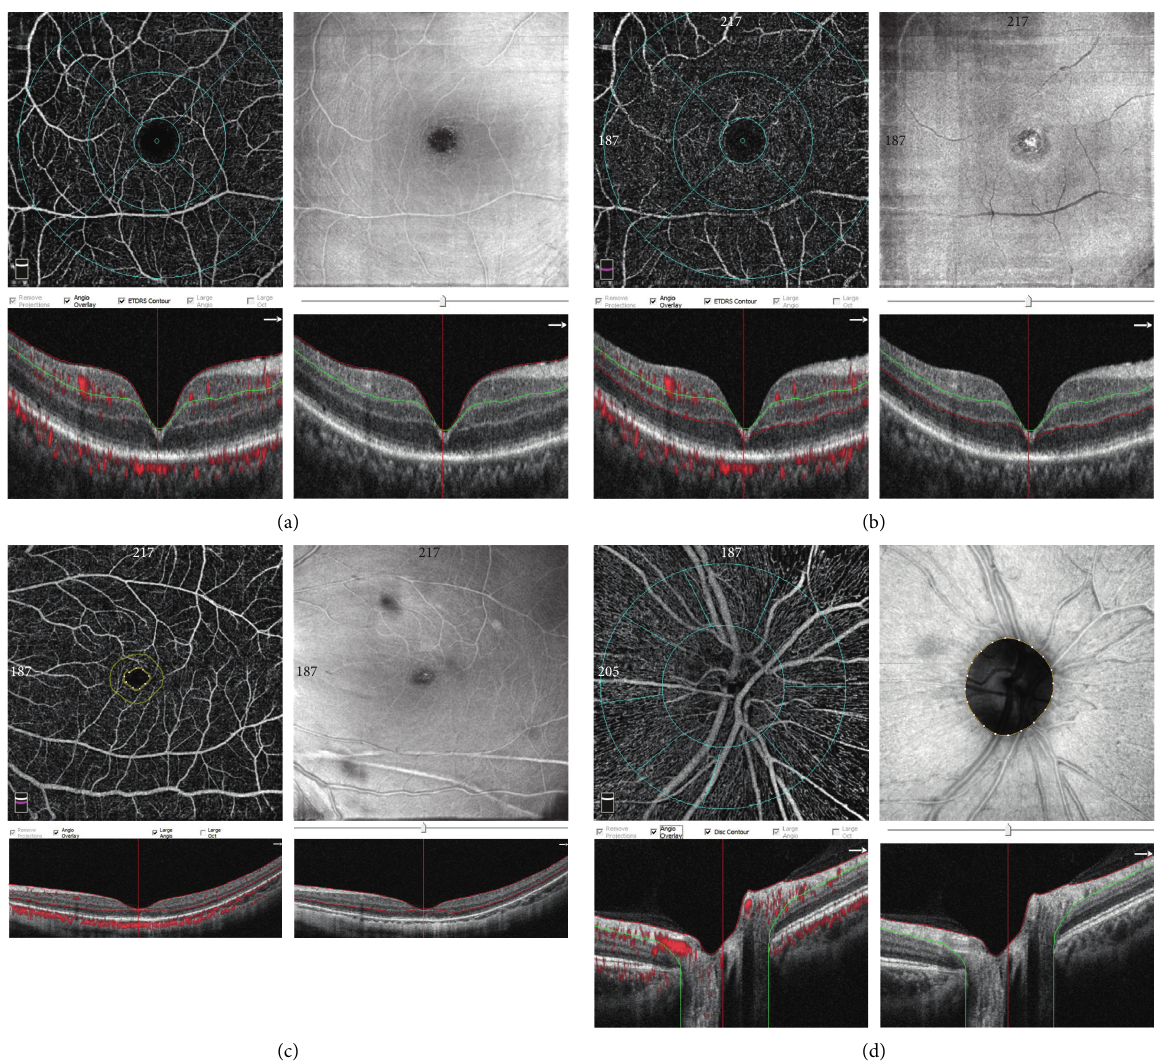
Figure 1: OCTA images with Angio Retina and Angio Disc mode. (a) Superficial foveal flow density (FFD) and parafoveal flow density (PFD): above, 6 × 6 mm en face angiogram; below, B scan image (red line � internal limiting membrane (ILM); green line � inner plexiform layer (IPL)). (b) Deep foveal flow density (FFD) and parafoveal flow density (PFD): above, 6 × 6mm en face angiogram; below, B scan image (green line � IPL; red line � outer plexiform layer (OPL)). (c) Foveal avascular zone (FAZ): area of the inner yellow circle. (d) Vessel density (VD) of optic nerve head (ONH) and peripapillary region: above, 6 × 6mm en face angiogram; below, B scan image (red line � ILM; green line � nerve fiber layer